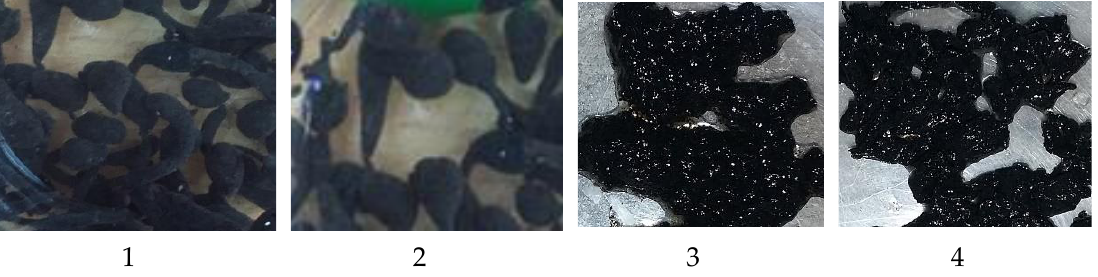
Figure 5. Freshly prepared GO-Ch composites with different GO contents: 1 — 63% (sample No. 1); 2 — 50% (sample No. 4); 3 — 60% (sample No. 5); 4 — 63.6% (sample No. 6).